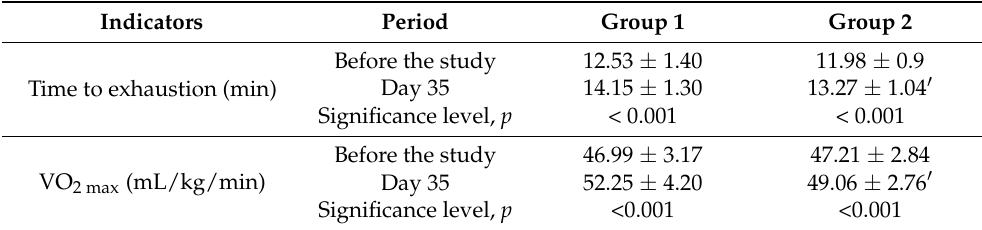
Table 3. Metabolic parameter during exhaustion incremental test by